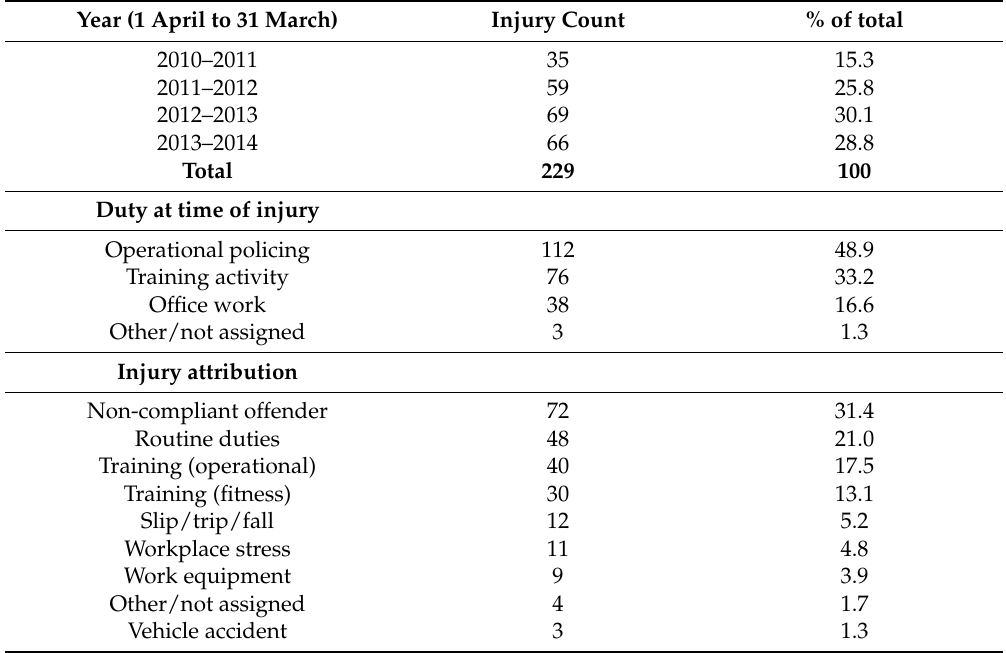
Table 2. Descriptive analysis of injury prevalence, duty at the time of injury, injury type and attribution, and body part